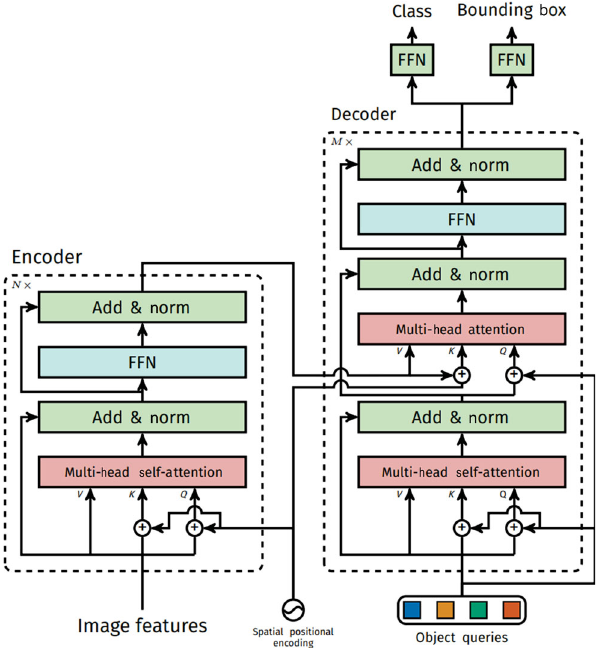
Fig. 9 Overall structure of DETR. Reproduced with permission from Ref. [24], c (cid:2) Springer Nature Switzerland AG 2020.